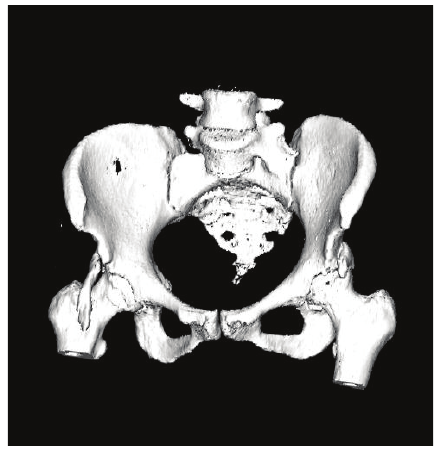
Figure 2: 3D-BT of the pelvis, presenting bilateral heterotopic ossification masses.